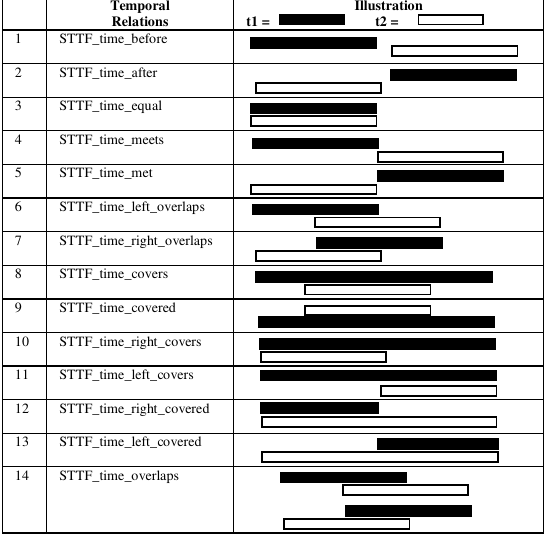
Table 1. Adapted temporal relations for bounded interval (Raza,